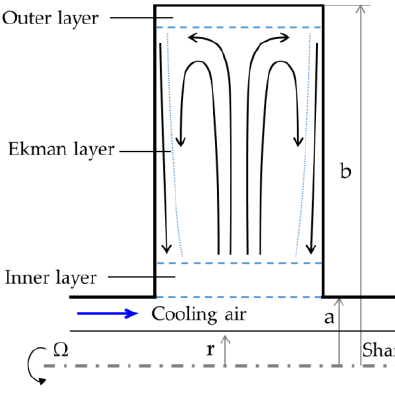
Figure 5. Assumed flow structure.